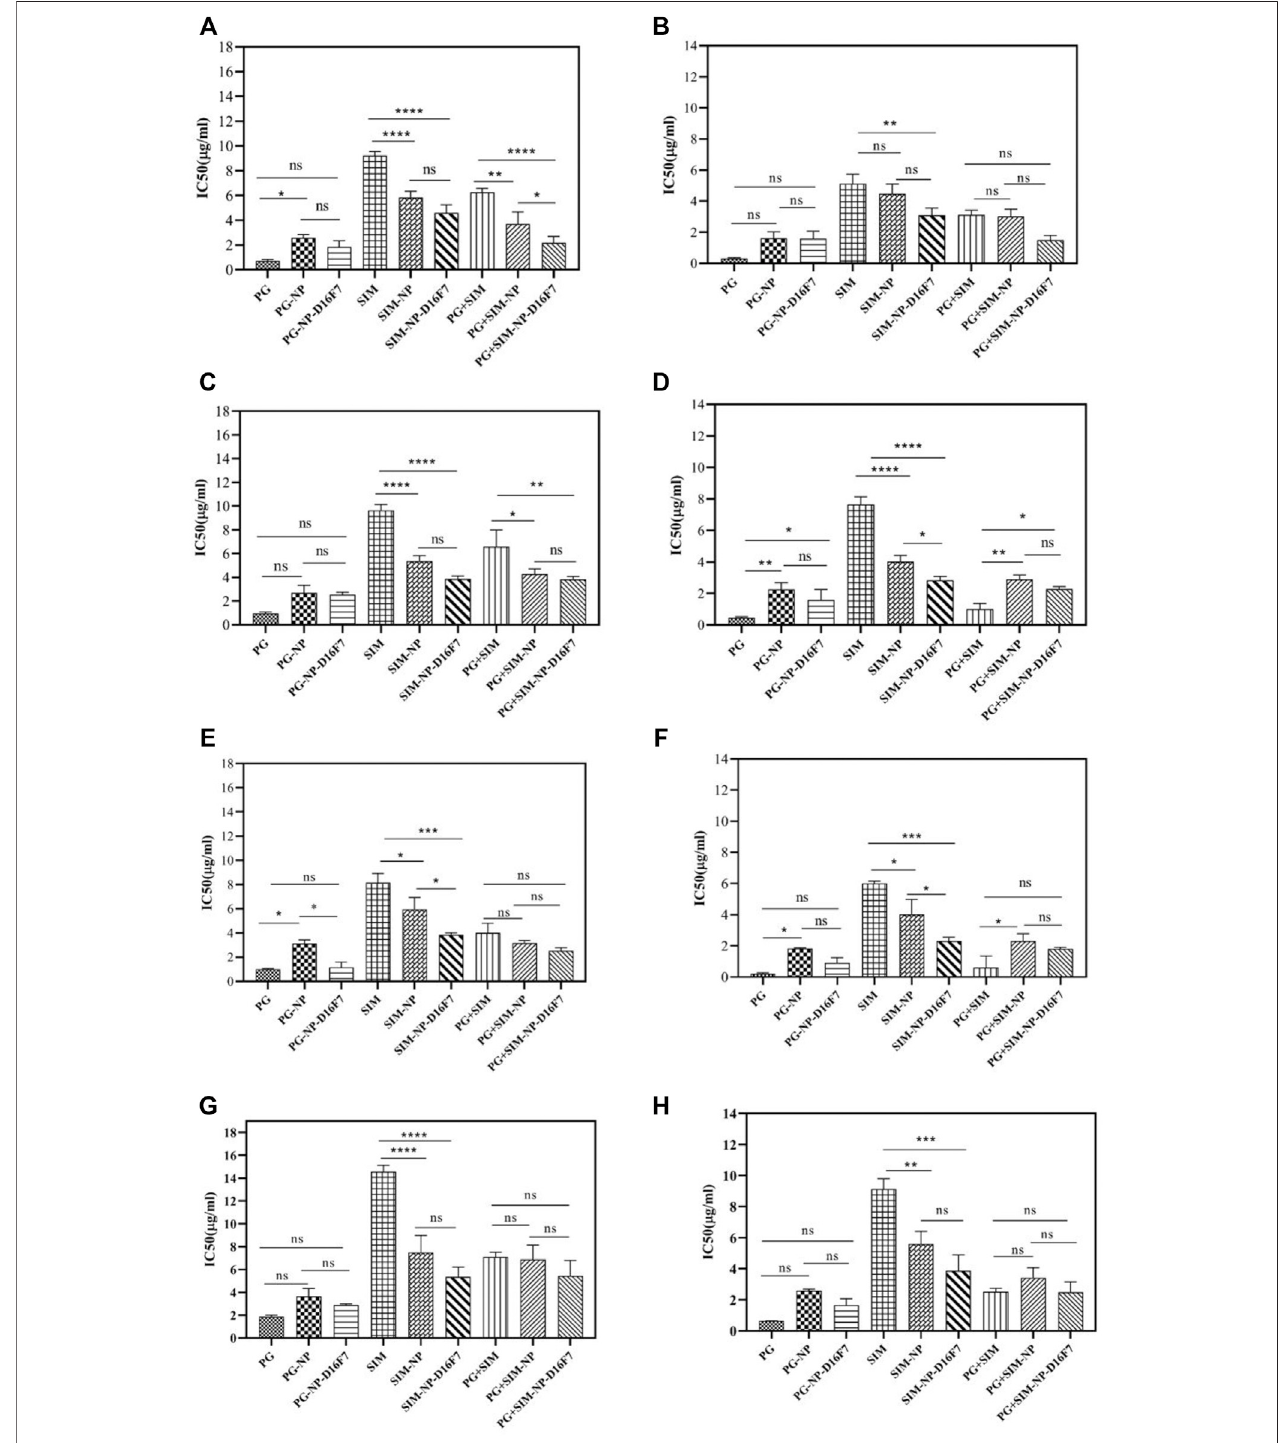
FIGURE 5 | IC 50 values of free drugs, drug-loaded, and D16F7-functionalized Ca-Gly BioMOFs on MCF-7 cell line after 24 h (A) and 48 h (B) ; on LnCap cells after 24 h (C) and 48 h (D) ; on U87MG cells after 24 h (E) and 48 h (F) , and on normal HSF cells after 24 h (G) and 48 h (H), respectively. Dataare mean ± SD. *indicated p < 0.05, **indicated p < 0.01, ***indicated p < 0.001 and p < ****indicate 0.0001 (compared with control group).